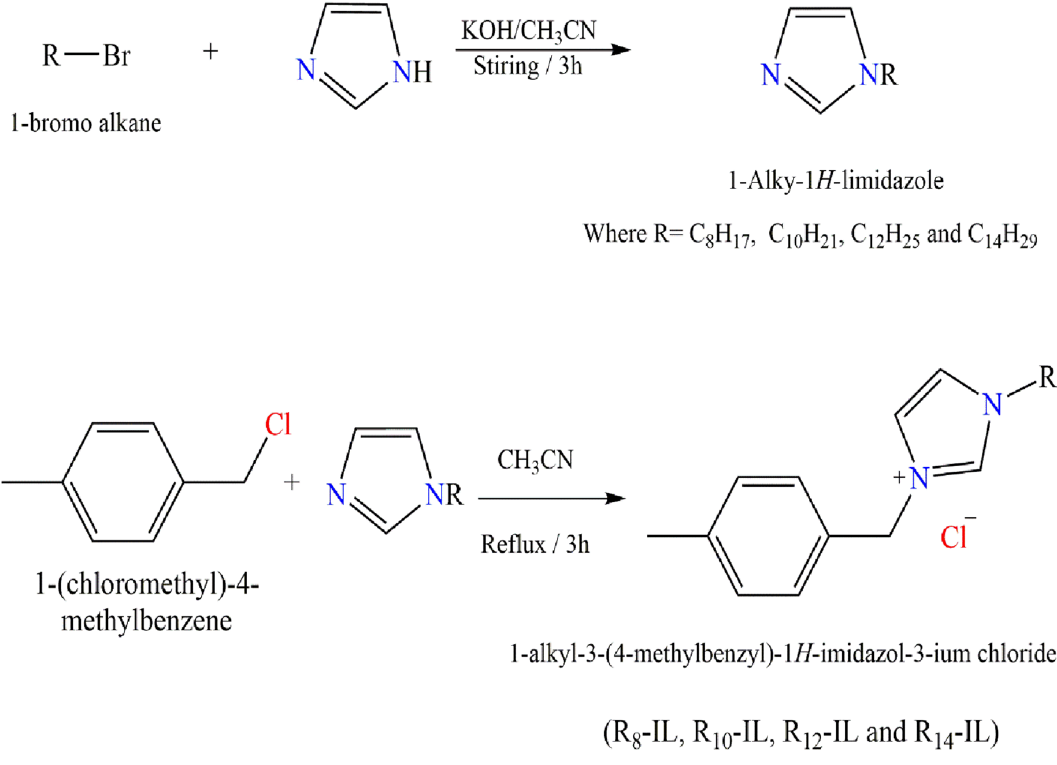
Figure 1. Synthesis of R 8 -IL, R 10 -IL, R 12 -IL, and R 14